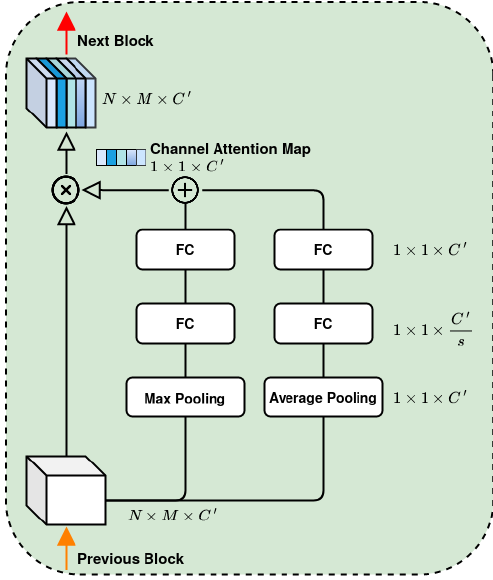
Figure 6. Channel Attention